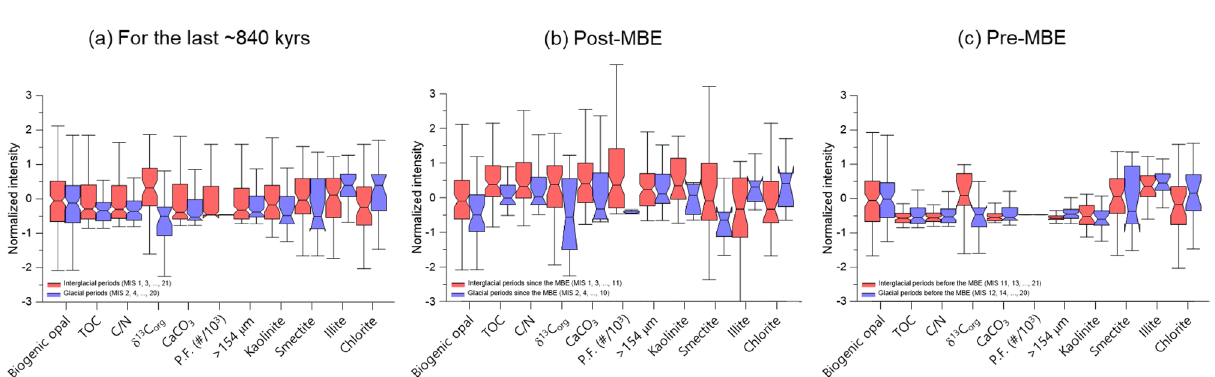
Figure 5. Box–Whisker plots showing the normalized intensity values of geochemical (biogenic opal, TOC, C/N, δ 13 C org , and CaCO 3 ), micropaleontological (planktonic foraminifera: P.F.), and mineralogical (kaolinite, smectite, illite, and chlorite) data of core ARC5-MA01 for ( a ) the last ~ 840 kyrs, ( b ) the post-MBE, and ( c ) the pre-MBE, respectively. Interquartile ranges multiplied by a factor of 1.5 are indicated as error bars. Red and blue boxes represent the interglacial and glacial periods,